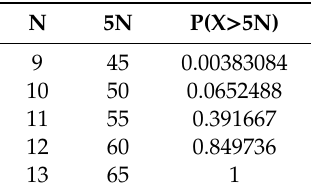
Table 4. Number of customers = 40N (k = 40).